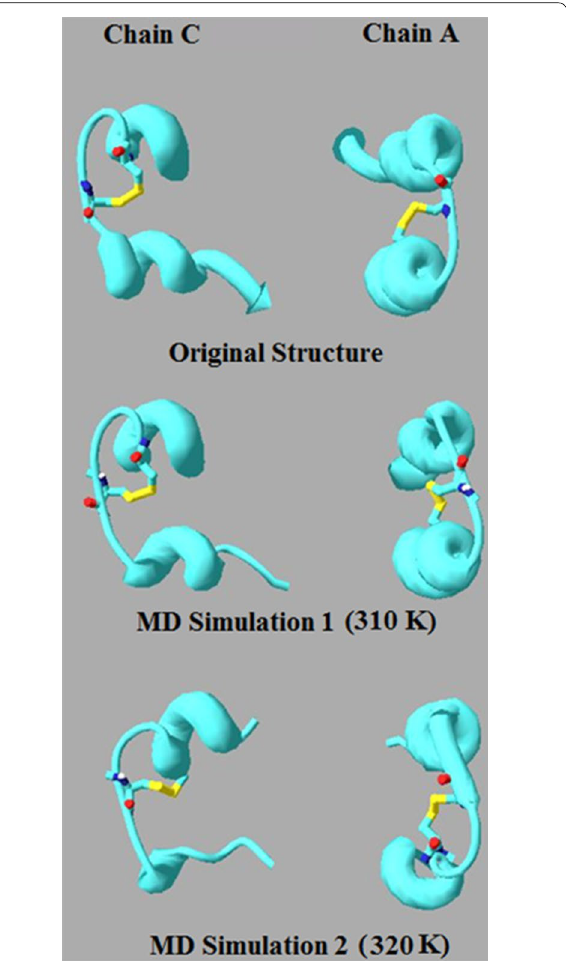
Fig. 26 HR insulin(Insugen I) comparison of secondary structures of chains C and A of the major conformation, showing the starting structure (with Cys6–Cys11 S–S bridge shown) and then after MD simulation for 300 ps at 310 and 320 K. Drawn with Swiss‑PdbViewer (Deep View)